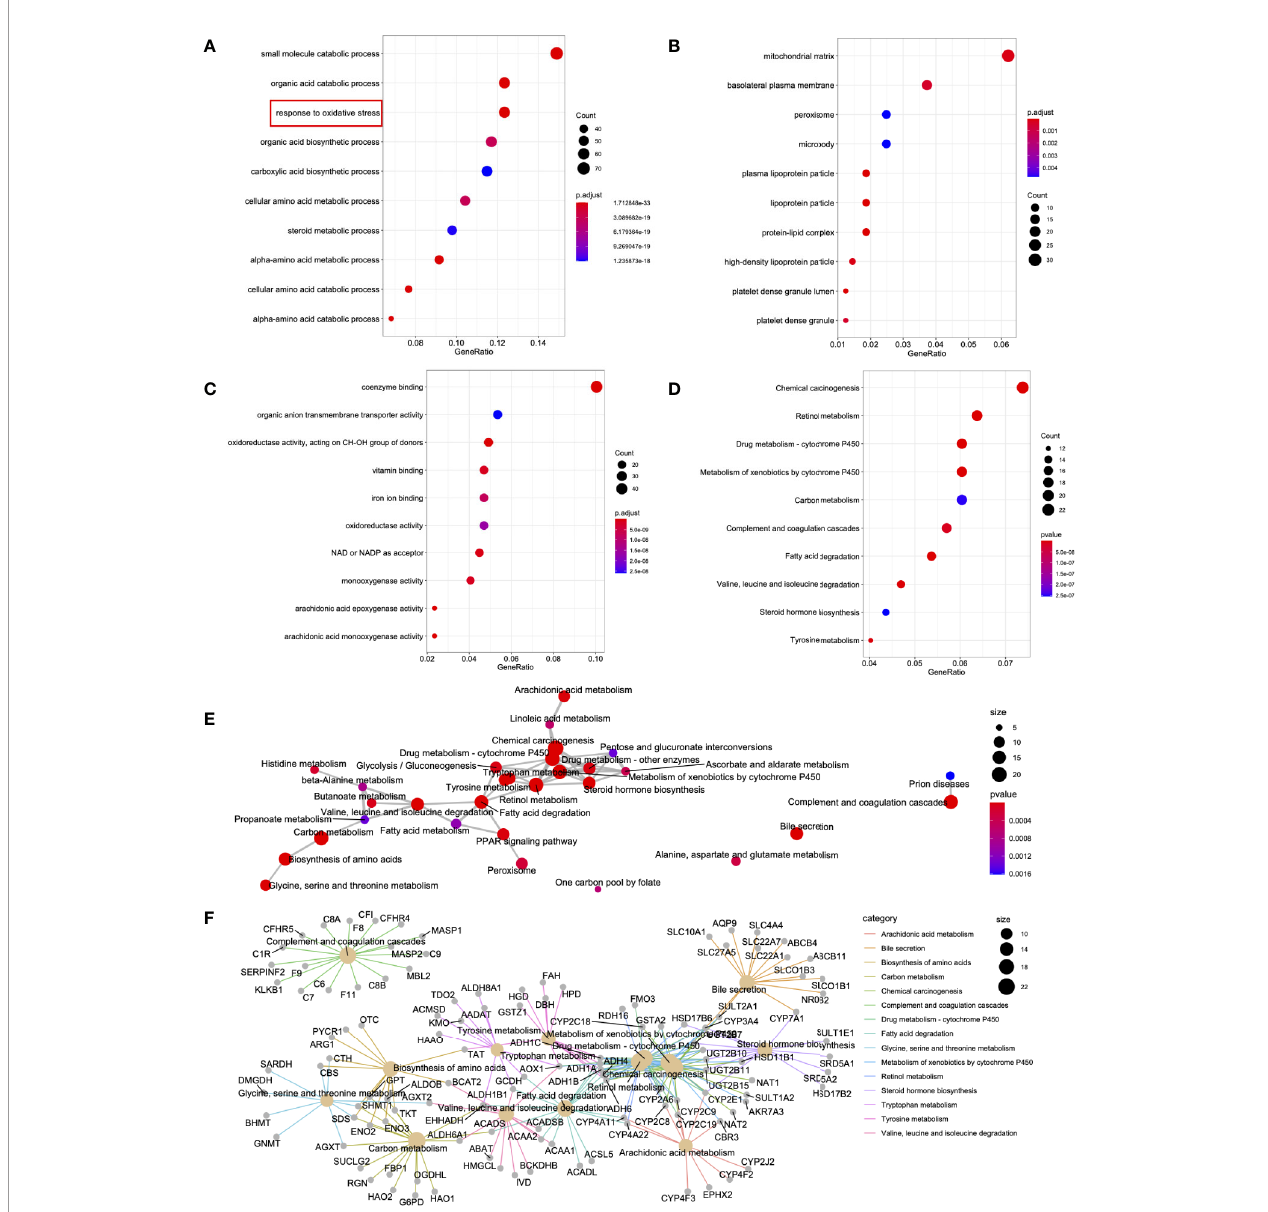
FIGURE 3 | DEG functional enrichment in the MEturquoise module. (A – D) The 10 GO terms and pathways with the greatest signi fi cance are shown. (E) The markedly altered pathways were connected to display the connections. The circle size in the network is directly proportional to the weighted connectivity degree. (F) Relationships of those markedly altered DEGs and pathways. The circle size represents the connection number between genes and